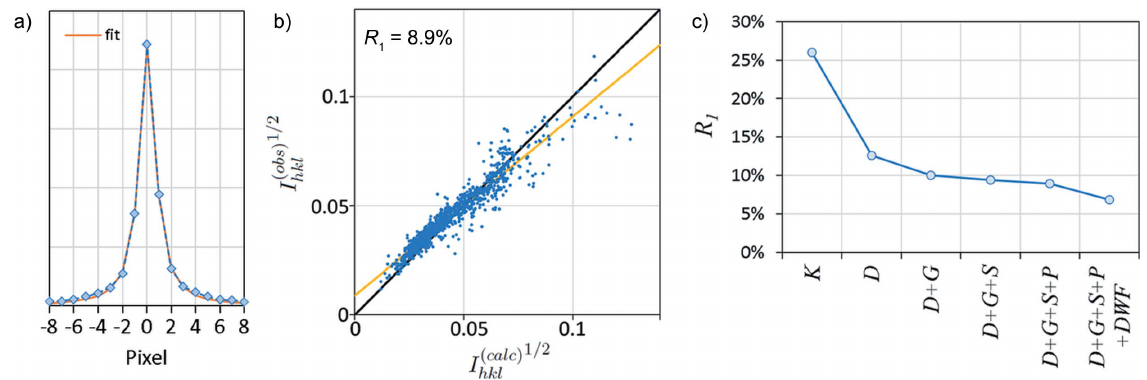
Figure 10 ( a ) The direct beam profile, obtained by averaging all frames in the Si cRED data and a Lorentzian fit. ( b ) R 1 calculation after optimizing the geometry and correcting for the slew rate and beam profile (specimen thickness 185 nm). R 1 = 8.9%. ( c ) R 1 for the kinematic model K and initial dynamical model D , with geometry optimization G , corrections for slew rate S and beam profile P , and refinement of Debye–Waller factor DWF .